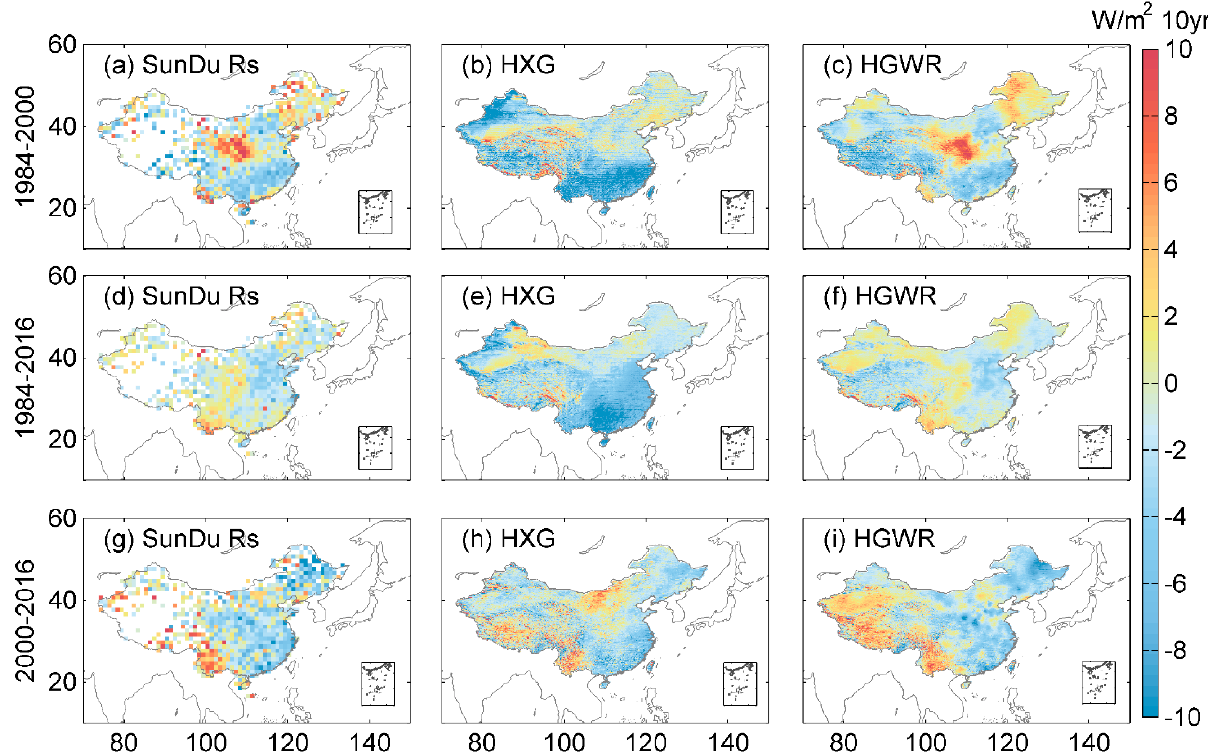
Figure 5. Spatial distributions of trends for R s from 1984 to 2000, 2000 to 2016 and 1984 to 2016. The first line ( a , b , c ) shows the R s trends from 1984 to 2000 based on SunDu-derived R s (SunDu Rs), ISCCP-HXG-derived R s (HXG) and ISCCP-HXG merged with SunDu-derived R s (HGWR). The second ( d , e , f ) and third lines ( g , h , i ) show the R s trends from 1984 to 2016 and 2000 to 2016, respectively.